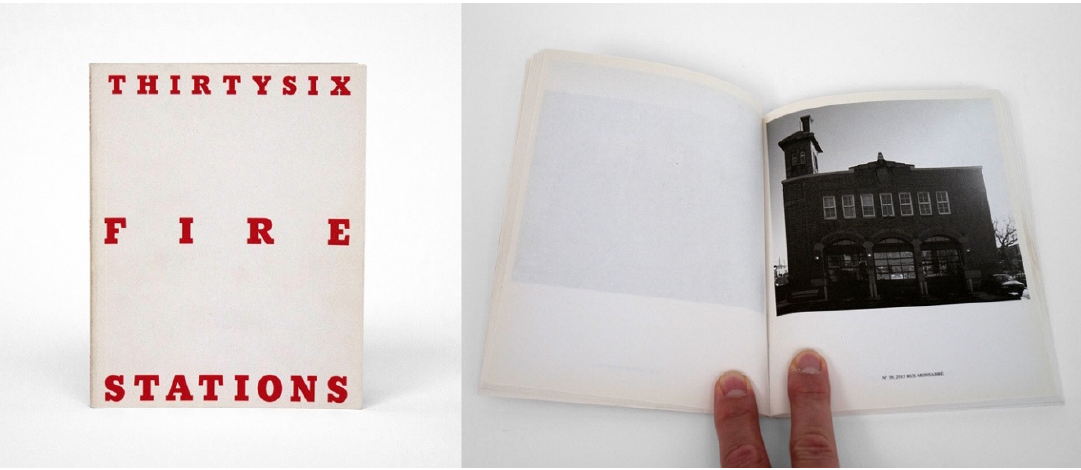
Figure 9. Yann Sérandour, Thirtysix Fire Stations , 2004. Figure 9. Yann S é randour, Thirtysix Fire Stations ,